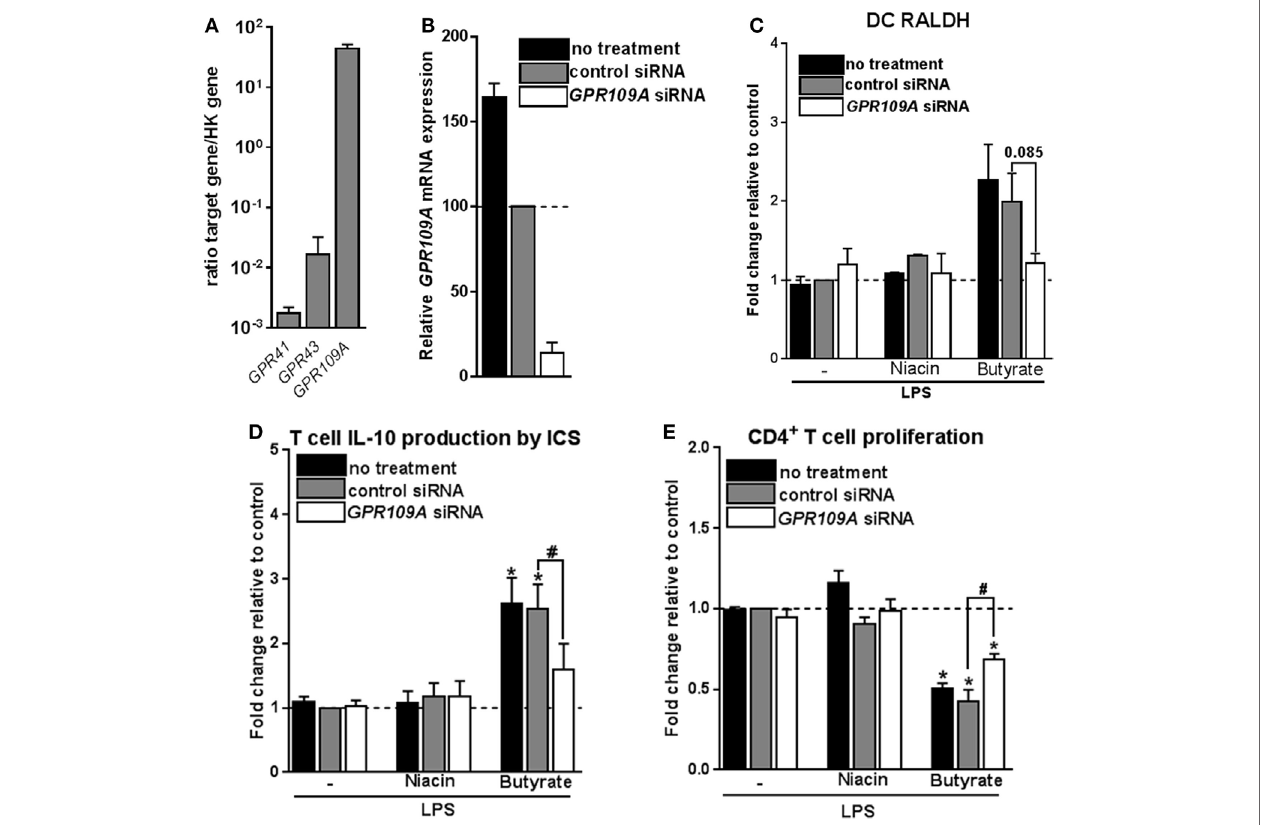
FigUre 5 | Signaling through G protein-coupled receptor (GPR) 109A by butyrate is required yet not sufficient for inducing type 1 regulatory T cells-promoting human tolDCs. (a) mRNA expression of indicated genes was quantified using real-time qPCR of unstimulated dendritic cells (DCs). Expression is shown relative to housekeeping gene beta-actin. (B–e) GPR109A expression was silenced by small interfering RNA (siRNA) on day 4 of DC differentiation after which (B) silencing efficacy was determined by real-time qPCR on day 6. (c) Retinaldehyde dehydrogenase (RALDH) activity induced by butyrate and GPR109A ligand niacin was assessed as described in Figure 3D . (D) IL-10 production by T cells as described in Figure 2B was determined, and (e) T-cell suppression assay was performed as described in Figure 2D . (a) Bar graphs represent means ± SEM of at least three experiments and (B–e) are shown as fold change relative to control conditions. * ,# p < 0.05, ** p < 0.01, *** p < 0.001 for significant differences with the control (*) or between test conditions ( # ) based on paired Student’s t